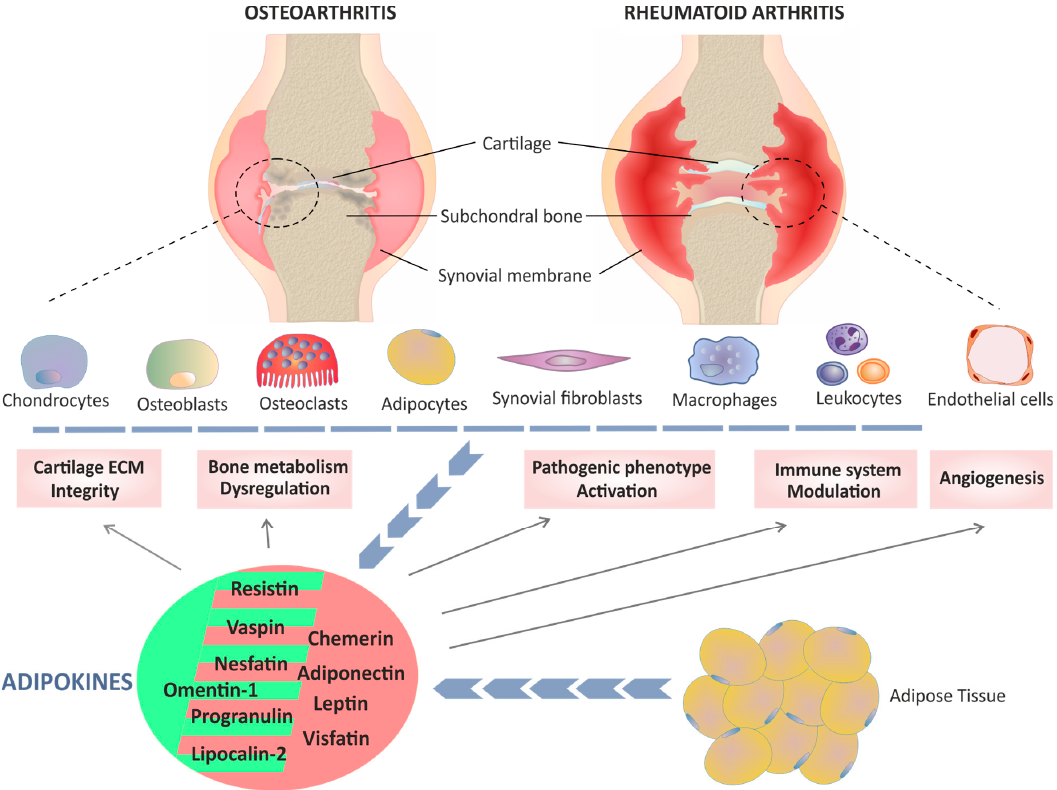
Figure 1. Graphical schematic representation of the role of classic and novel adipokines in two rheumatic diseases: osteoarthritis (OA) and rheumatoid arthritis (RA). A variety of adipokines produced by adipose tissue (blue line of arrows) as well as by chondrocytes, osteoclasts, osteoblasts, synoviocytes and inflammatory cells (blue dashed line and blue line formed by arrows), contribute to multiple pathological mechanisms (solid arrows) involved in the development of OA and RA. Although there are di ff erences between the pathogenesis of OA and RA, common mechanisms have also been identified that a ff ect cartilage extracellular matrix (ECM) integrity, dysregulation of bone metabolism, the pathogenic phenotype of synovial fibroblasts and macrophages, modulation of the immune system and synovial angiogenesis. Depending on the context, both pro- and anti-inflammatory e ff ects have been associated with some adipokines, such as visfatin and resistin. Adipokines with a dominant pro-inflammatory role in arthritis are shown with a light red background, whereas those in which an anti-inflammatory action predominates are shown with a green background.